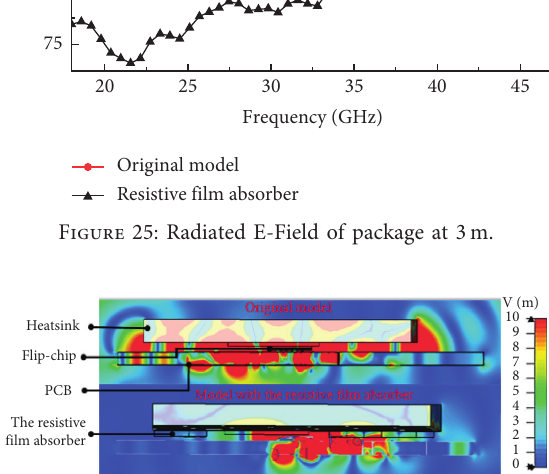
Figure 26: Near-field electric field distribution with and without resistive film absorber.